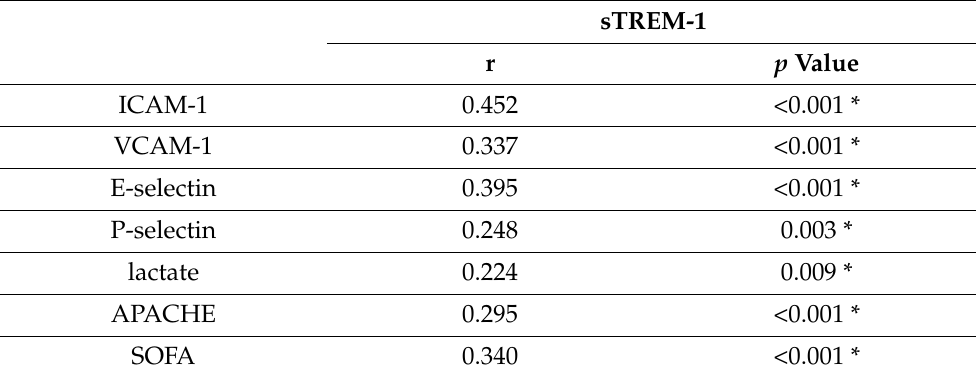
Table 2. Correlation analysis between sTREM-1 and biomarkers for endothelium dysfunction and clinical severity